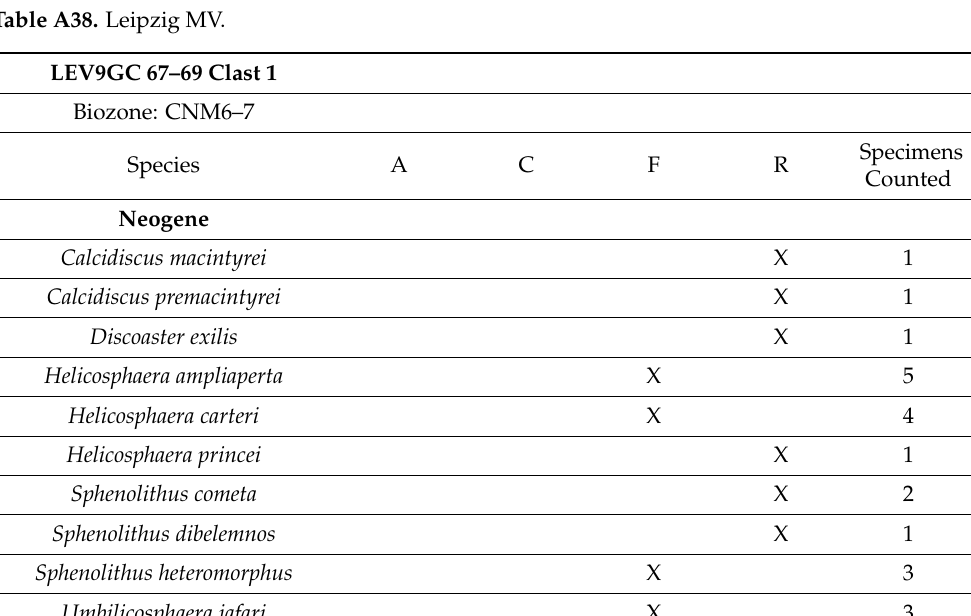
Table A38. Leipzig